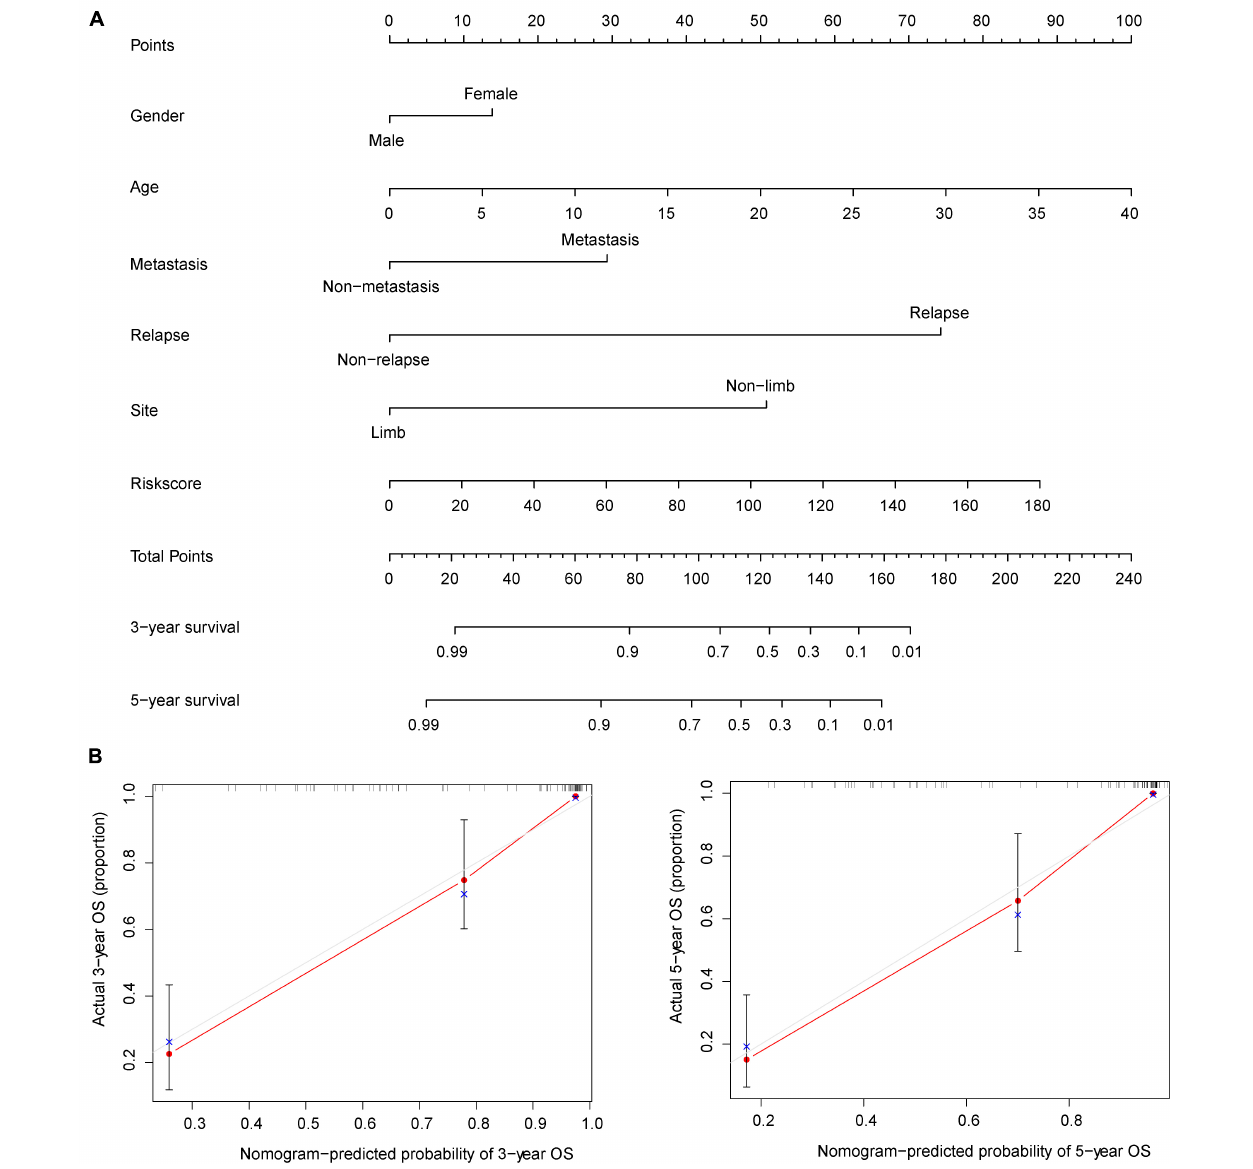
Osteosarcoma cells were inoculated in six-well plates and cultured for 12 h, 5-ethynyl-2 (cid:48) -deoxyuridine (EdU, Beyotime, Shanghai, China), was added. The final concentration of EdU was 10 µ M. It was incubated in an incubator at 37 ◦ C for 2 h and fixed with 4% paraformaldehyde. A total of 1 mL of osmotic solution was added to each well and incubate at room temperature for 15 min. A total of 0.5 mL click reaction solution was added to each well and incubate at room temperature in dark for 30 min. Finally, the nuclei were stained with DAPI (Beyotime, Shanghai,